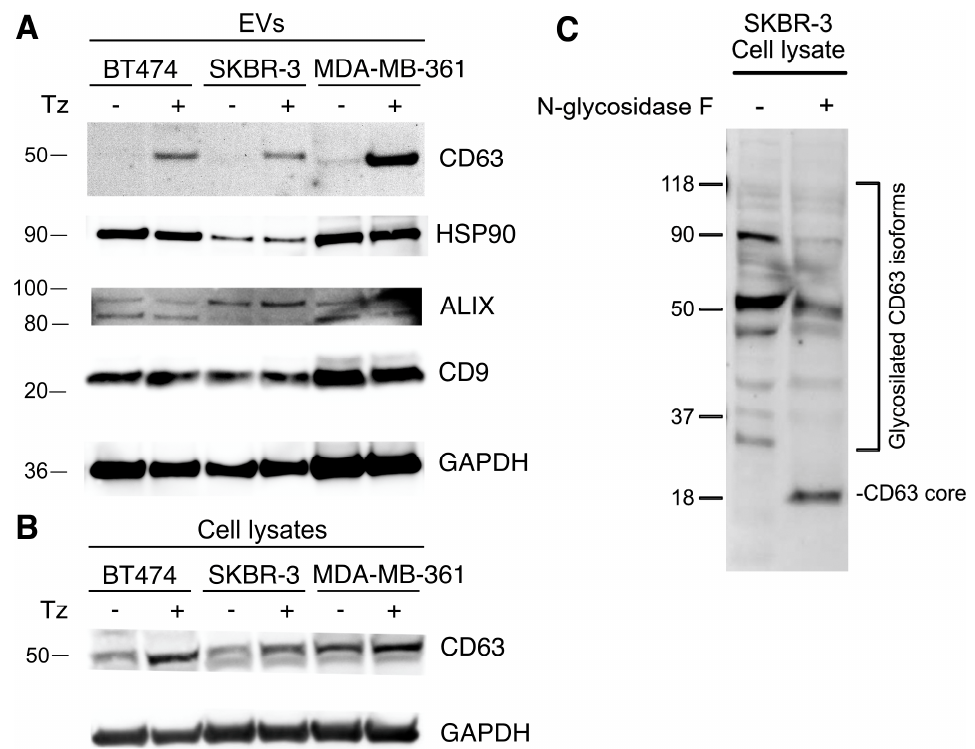
Figure 2. Immunoblot analyses of ERBB2 + cancer cell lines, lysates, and EVs purified from conditioned media. Cells were either treated with human normal IgGs (Tz − condition) or with 10 µg/mL of Tz (Tz+ condition) for 72 h. Migration of molecular mass standards expressed in kDa, are indicated on the left. ( A ) Immunoblot analysis of EVs purified from conditioned media of BT474, SKBR-3, and MDA-MB-361 cell lines. Antibody tests are indicated on the right. GAPDH was used as the loading control. ( B ) Immunoblot analysis of the expression levels of the CD63 50 kDa isoform in BT474, SKBR-3, and MDA-MB-361 cell layers. GAPDH was used as the loading control. ( C ) Immunoblot analysis of cell lysates treated with reaction buffer (N-glycosidase F − condition) or with buffer plus enzyme (N-glycosidase F+ condition). Lysates were obtained from SKBR-3 cells treated with Tz. Signals from glycosylated CD36 isoforms and the 18 kDa CD63 core protein are indicated on the right.